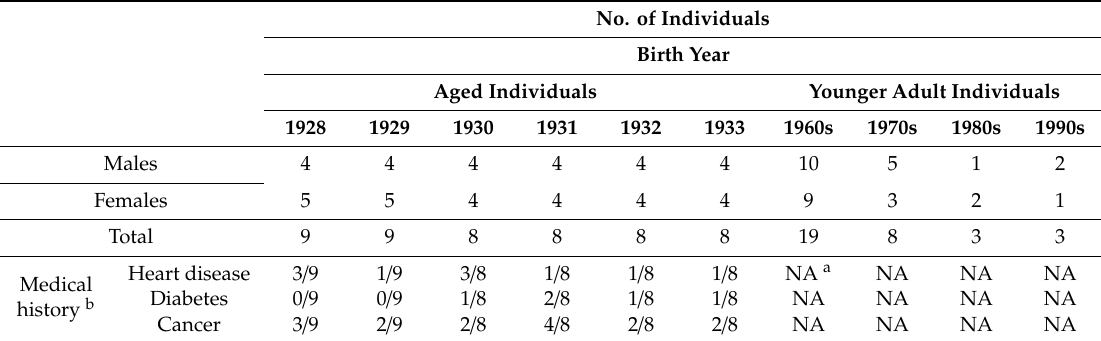
Table 1. Characteristics of the participants in this